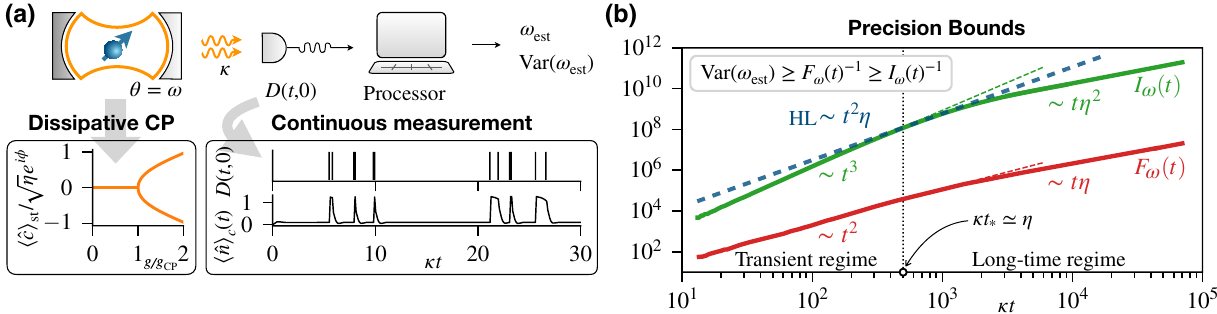
κt Long-time regimeTransient regime κt FIG. 1. (a) The open Rabi model as a model system demonstrating criticality-enhanced sensing via continuous measurement. We consider the sensing of the cavity mode frequency ω as an illustration. The cavity leaks photons at a rate κ , counted continuously by a photon detector. The model parameters are tuned to a dissipative CP g CP , where its steady state undergoes a continuous phase transition (see the text). Here η is the effective system size, φ = arctan ( 2 κ/ω) . A sensing interrogation corresponds to a quantum trajectory consisting of the continuously detected signal D ( t , 0 ) and the associated conditional evolution of the open system, as exemplified by the cavity mode occupation (cid:6)ˆ n (cid:5) c ( t ) . Processing D ( t , 0 ) (e.g., via Bayesian inference [43–45]) provides an estimator ω est with an imprecision (variance) Var (ω est ) . (b) Scaling of the precision bounds at dissipative criticality, including the global QFI of the joint system and environment I ω ( t ) , and the FI F ω ( t ) of the detected signal. Both quantities manifest algebraic scaling with respect to t and η , and for illustration, we show the numerical results for η = 500, ω = 1 and κ = 0.1. With respect to the interrogation time t , the precision bounds obeys (super-)Heisenberg scaling in the transient regime, t (cid:2) t ∗ (cid:9) η/κ , whereas linear scaling in the long-time √ η (not shown). The scaling regime, t (cid:10) t ∗ . The scaling should be contrasted with the HL ∼ t 2 η (thick dashed blue) and the SQL ∼ t exponents of the global QFI can be related to the critical exponents z = 1, (cid:10) ˆ n = − 1 / 2 and the spatial dimension d = 0 via the general formulas (12) and